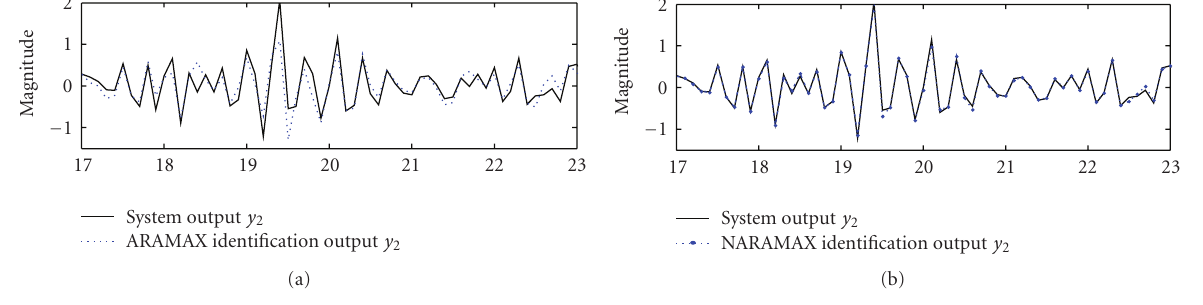
Figure 6: The trajectories of the output 2 for ARMAX and NARMAX